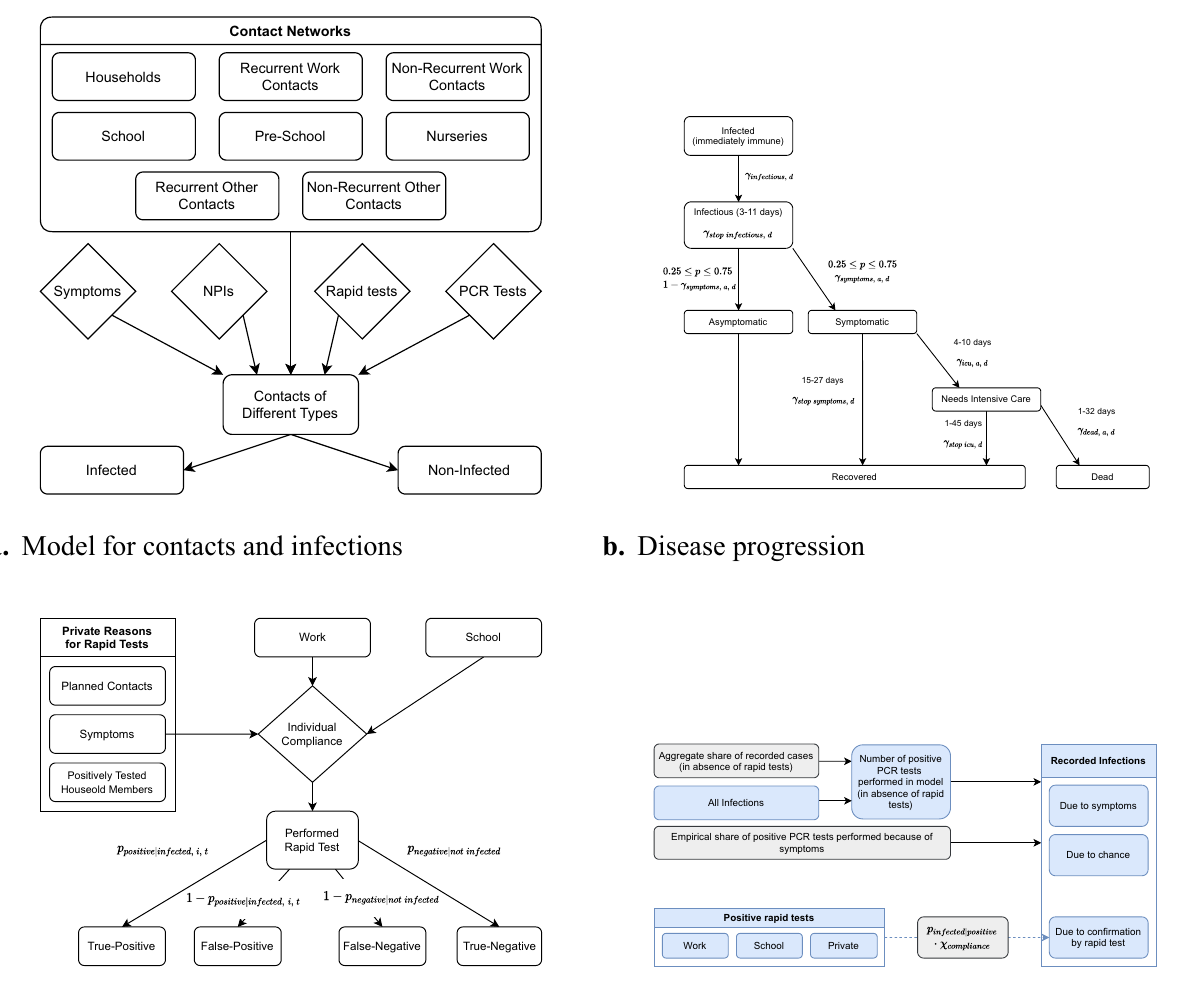
Figure 1. A description of the model can be found in Supplementary Material B. ( a ) The influence of an agent’s contacts to other agents on infections. Demographic characteristics set the baseline number of contacts in different networks ( η ). The agents may reduce the number of contacts due to NPIs, showing symptoms, or testing positively for SARS-CoV-2 ( τ ). Infections may occur when a susceptible agent meets an infectious agent; the probability depends on the type of contact ( β c ), on seasonality ( κ c ), and on NPIs ( ρ c , t ). If infected, the infection progresses as depicted in ( b ). If rapid tests are available, agents’ demand is modeled as in ( c ). All reasons trigger a test only for a fraction of individuals depending on an individual compliance parameter; the thresholds for triggering test demand differ across reasons and they may depend on calendar time ( π c , t and τ c , t ). ( d ) The model of translating all infections in the simulated data to age-specific recorded infections. The model uses data on the aggregate share of recorded cases ( ψ ), the share of positive PCR tests triggered by symptoms ( χ symptom ), and the false positive rate of rapid tests ( p positive | infected , i , t ). The lower part of the graph is relevant only for periods where rapid tests are available. All parameters are explained in Supplementary Material